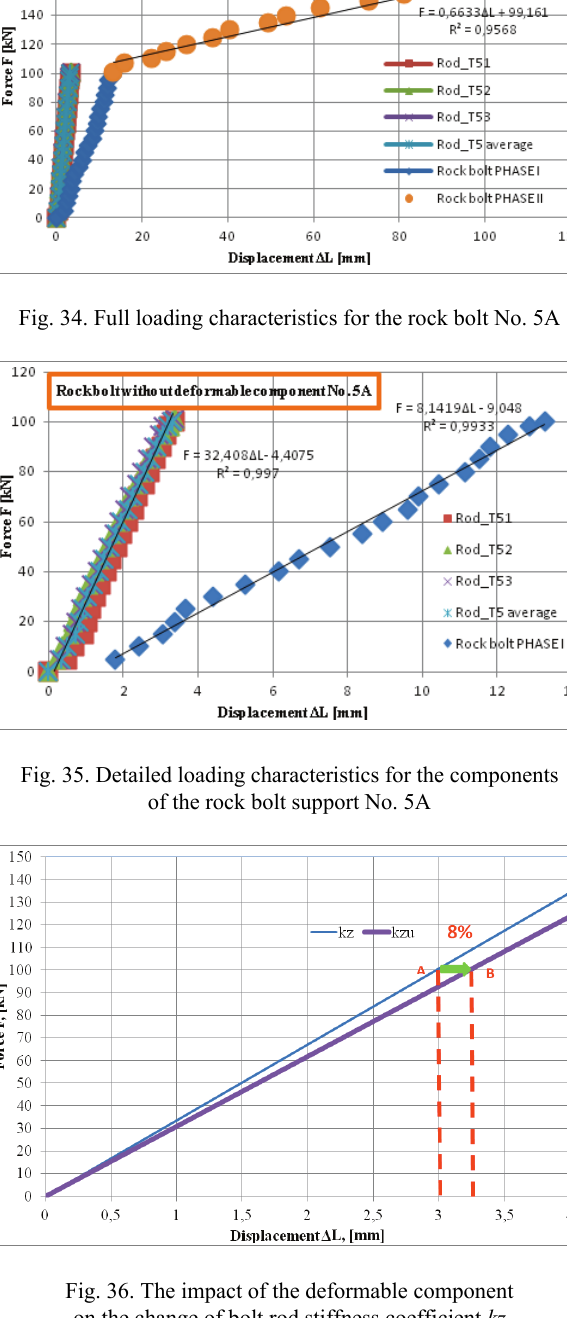
Fig. 36. The impact of the deformable component on the change of bolt rod stiffness coefficient kz